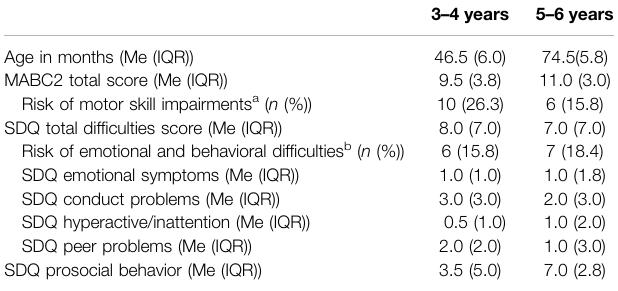
TABLE 1 | Descriptive statistics ( N (cid:1) 38, 15 boys, 23 girls). TABLE 2 | Logistic regression analysis